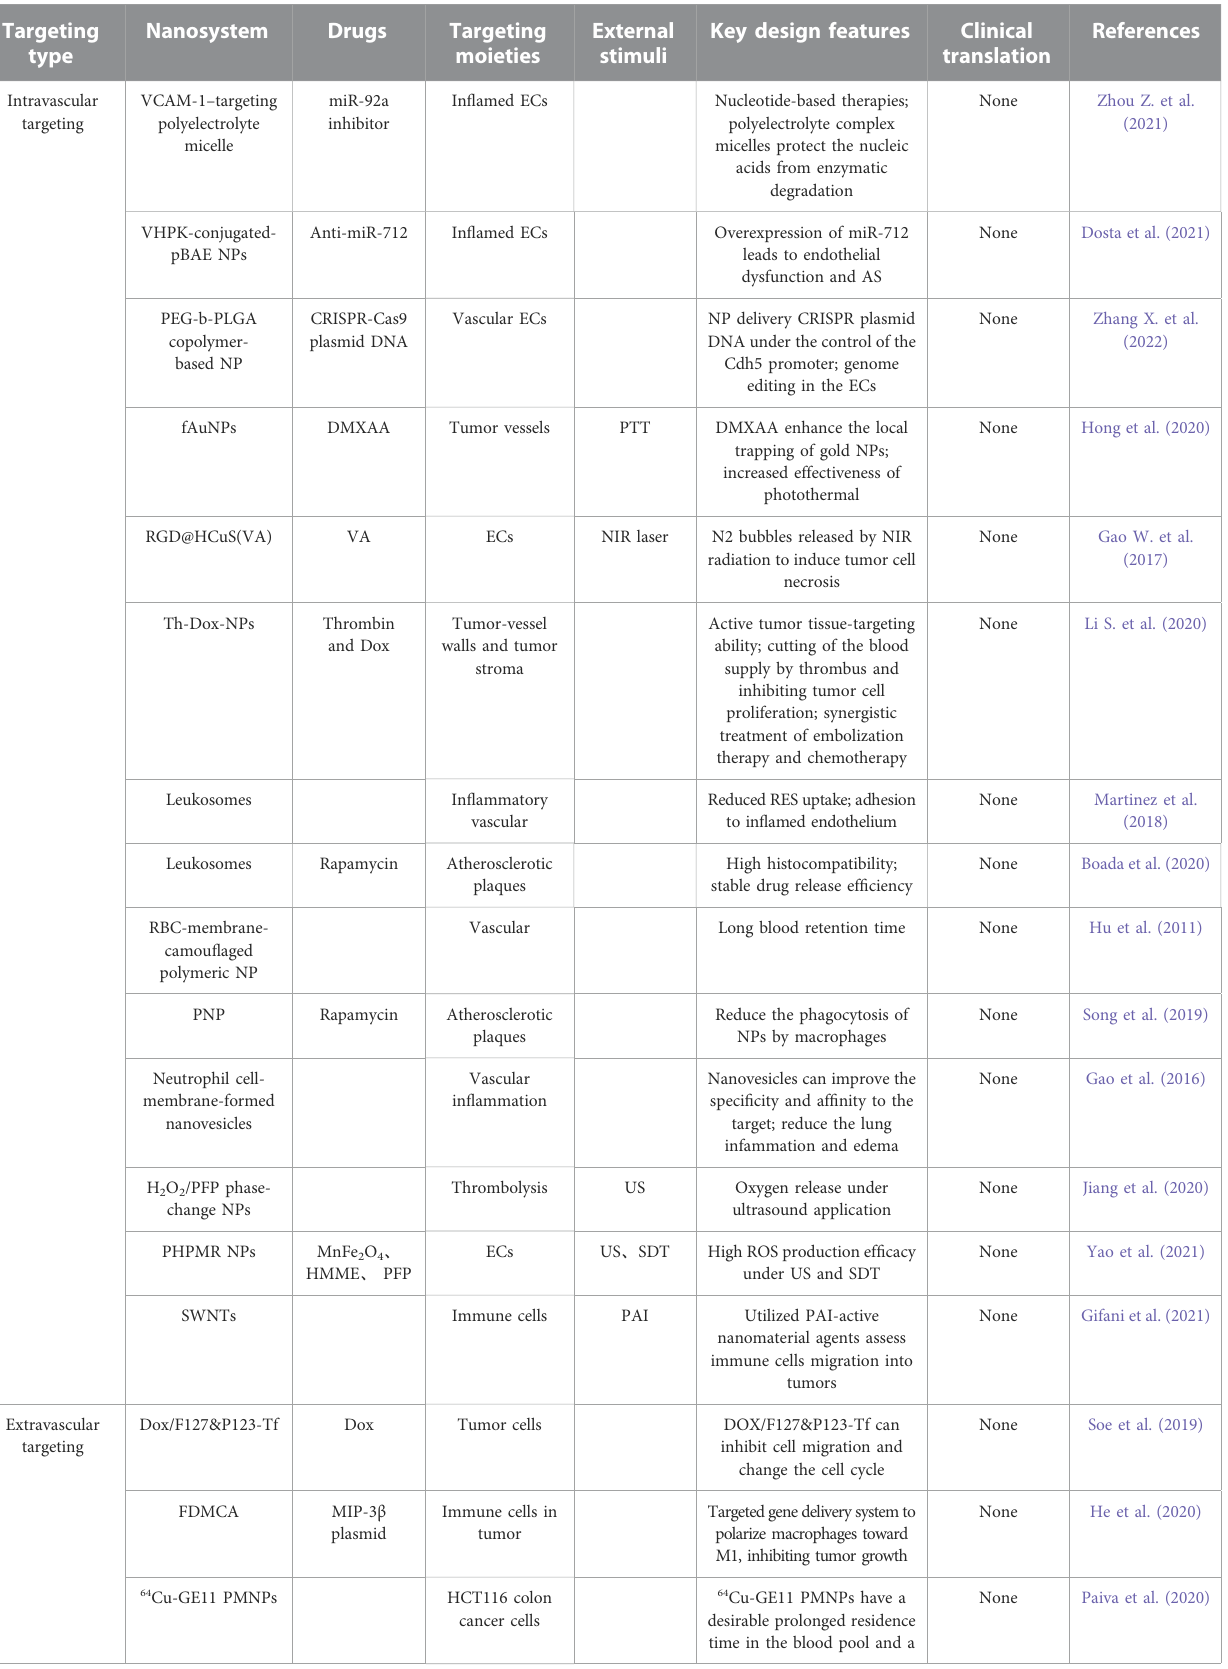
TABLE 1 The design of nano-DDS in endovascular and extravascular